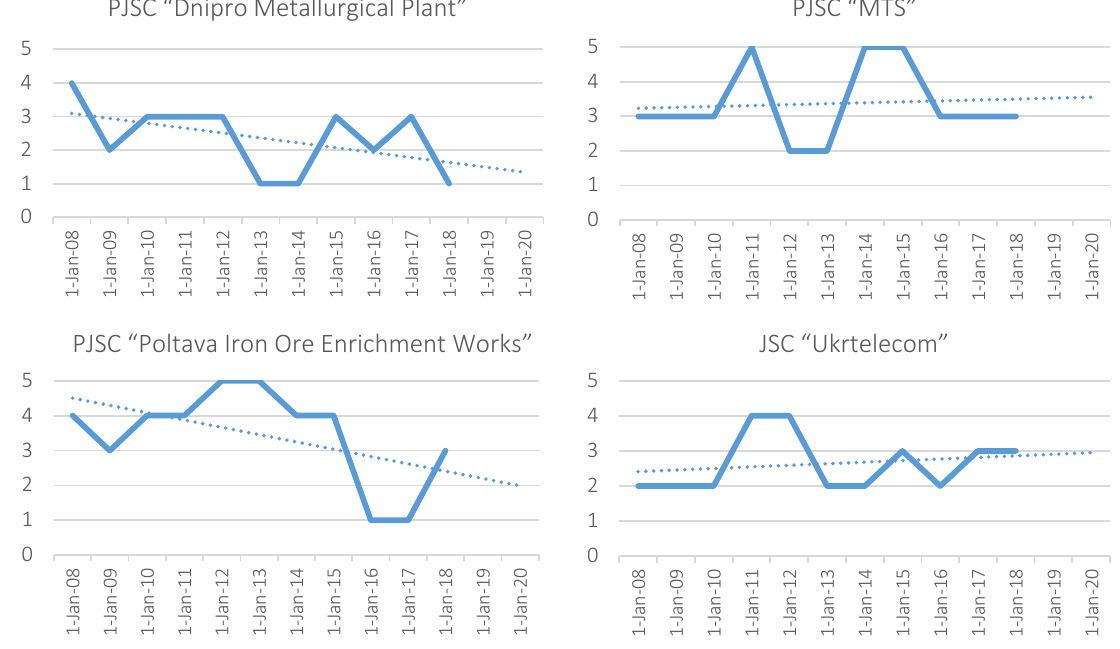
Figure 6. Group of Ukrainian companies under crisis (within the relevant